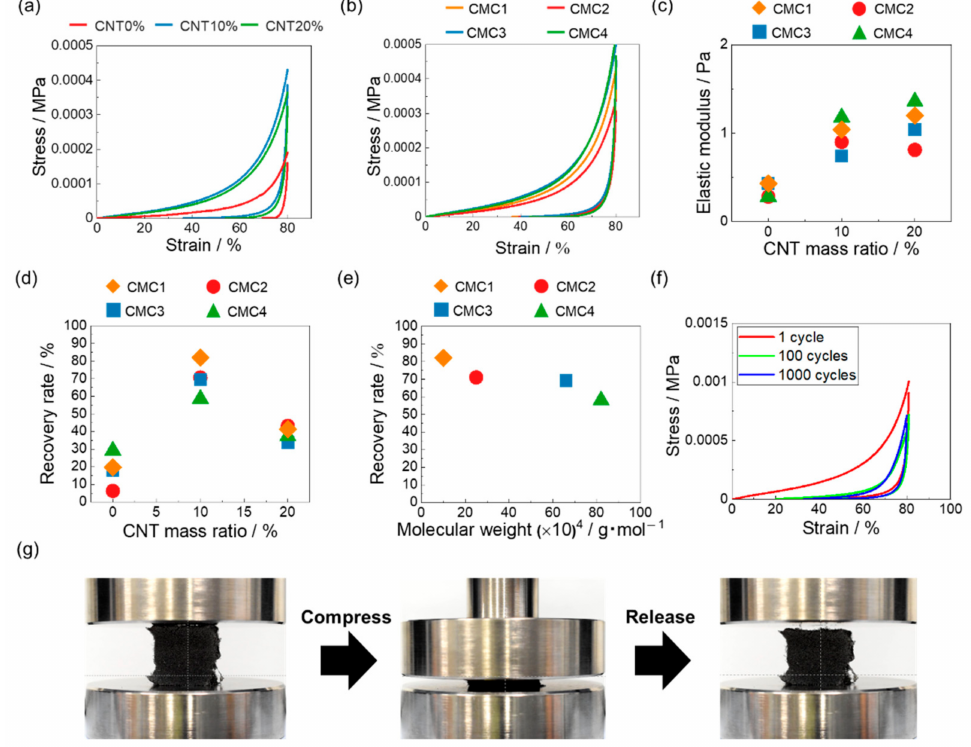
Figure 6. ( a ) Stress–strain curves of CNT/CMC2(1.3_X) with different CNT mass ratios (X = 0, 10, 20%). ( b ) Stress–strain curves of CNT/CMCX(1.3_10) with different CMC molecular weights (X = 1–4). ( c ) Relationship between CNT mass ratio and elastic modulus of the samples with different CMC molecular weights. ( d ) Relationship between CNT mass ratio and recovery rate of the samples with different CMC molecular weights. ( e ) Relationship between CMC molecular weight and recovery rate of CNT/CMCX(1.3_10). ( f ) Stress–strain curve after the cycle compression test for CNT/CMC1(1.3_10). ( g ) Photographs during the recovery test of